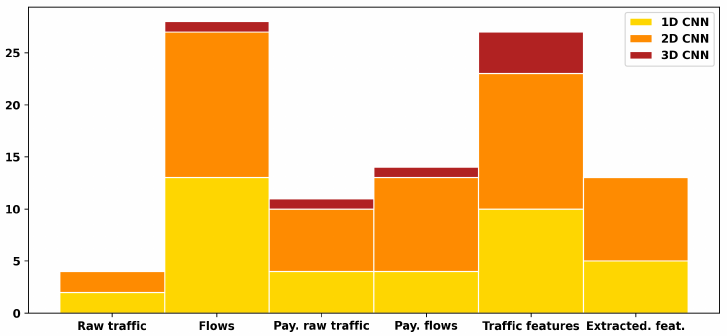
Figure 8. The popularity of discussed transformation methods, with the CNN